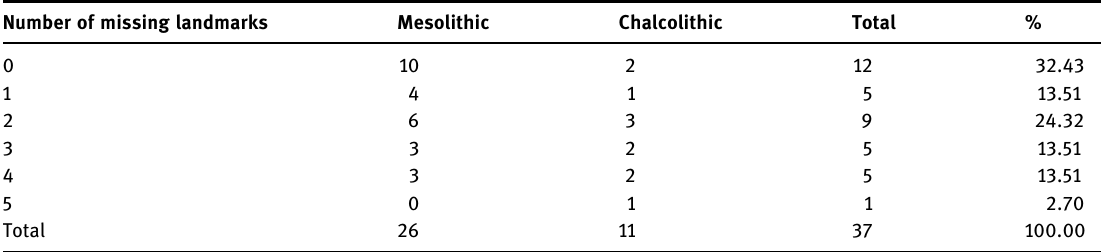
Table A1: Number of missing landmarks per specimen in the Mesolithic and Chalcolithic samples Number of missing landmarks